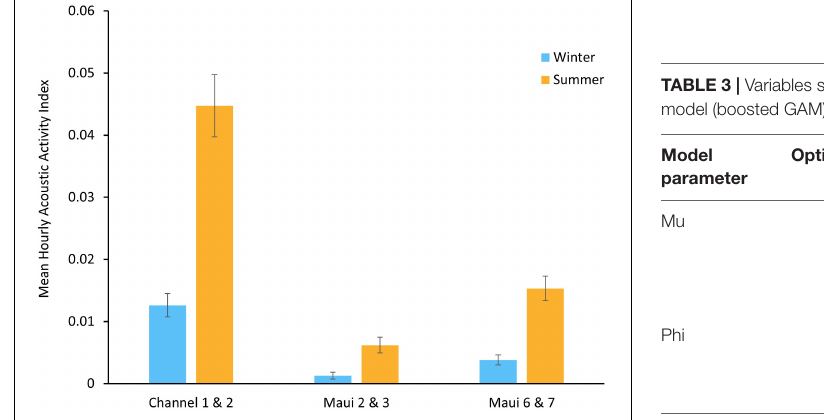
FIGURE 4 | Mean hourly Acoustic Activity Index (AAI), ranging from 0 to 3.5, of winter and summer Ecological Acoustic Recorder (EAR) deployments in the same locations. Error bars represent the standard error of the mean ( ± SEM).